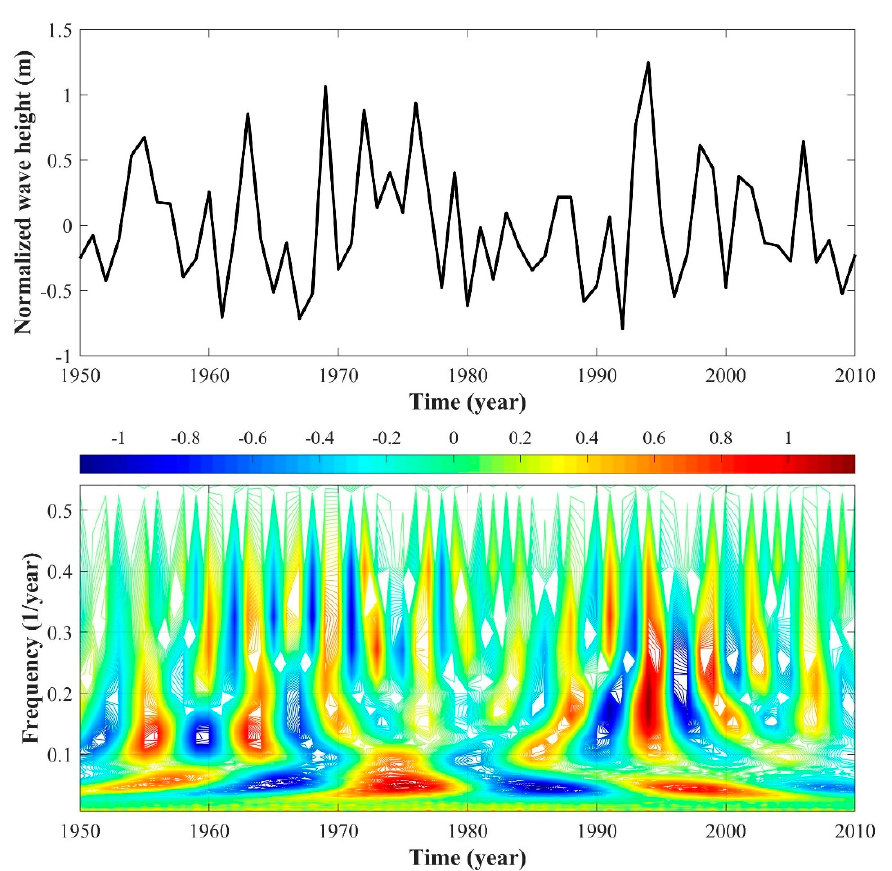
Figure 8. Fluctuations of normalized maximum annual wave time series (mean multi-annual was removed) (upper panel) and wavelet transformation (lower panel).